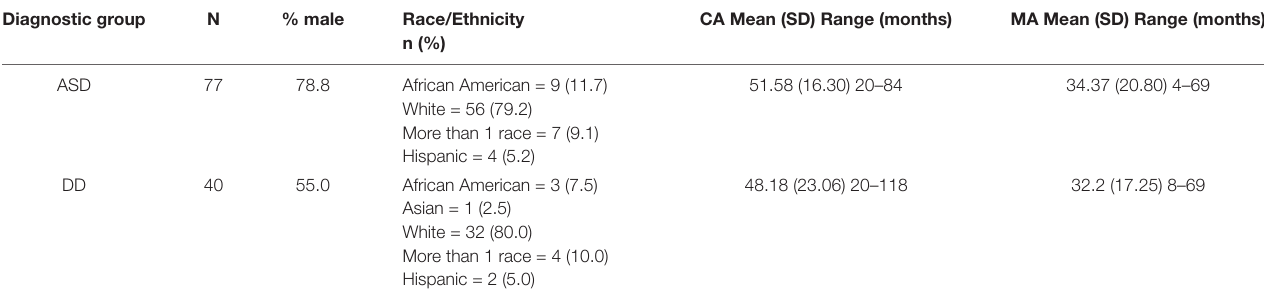
CA Mean (SD) Range (months) MA Mean (SD) Range (months) n (%)